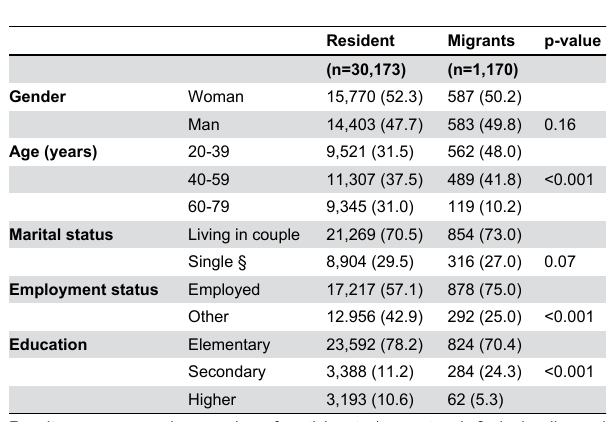
Table 2. Cardiovascular risk factors prevalence and screening, and health care utilization, by migrant